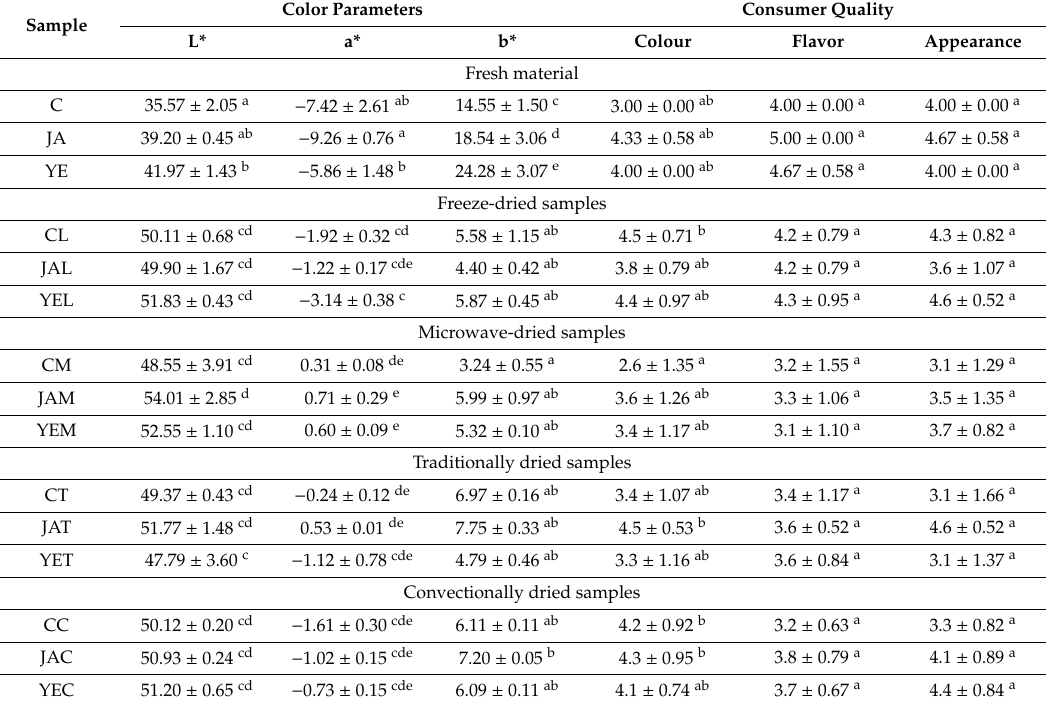
Table 2. E ff ect of elicitation and drying method on color parameters and consumer quality of lovage.